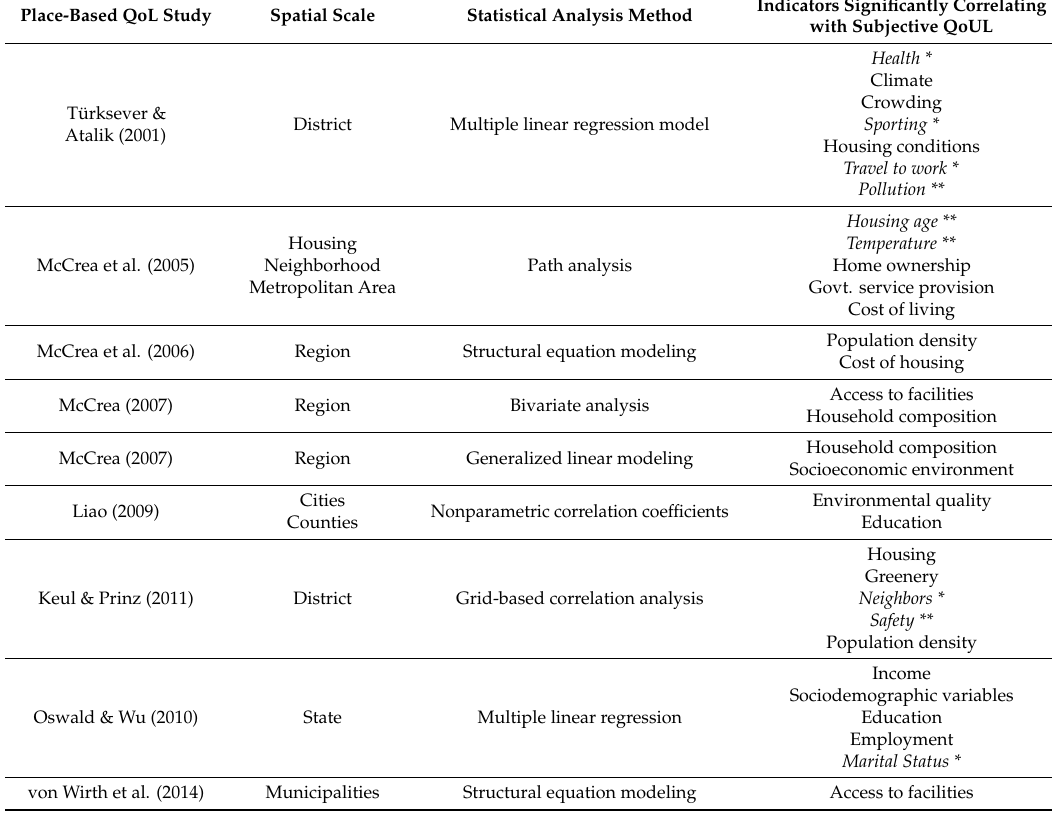
Table 1. Quality of urban life (QoUL) indicators studied in previous